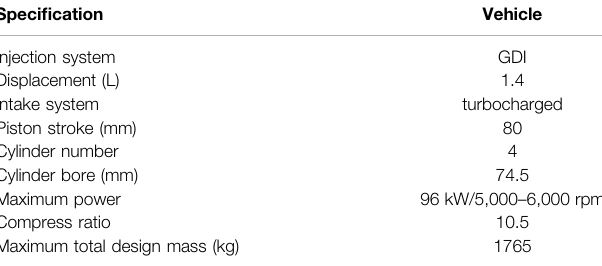
TABLE 1 | Engine speci fi cations.